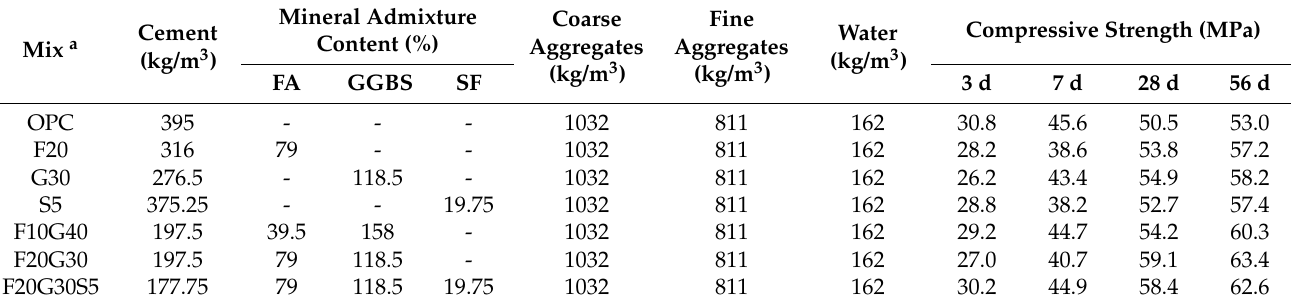
Table 5. Mixture proportions and compressive strength of